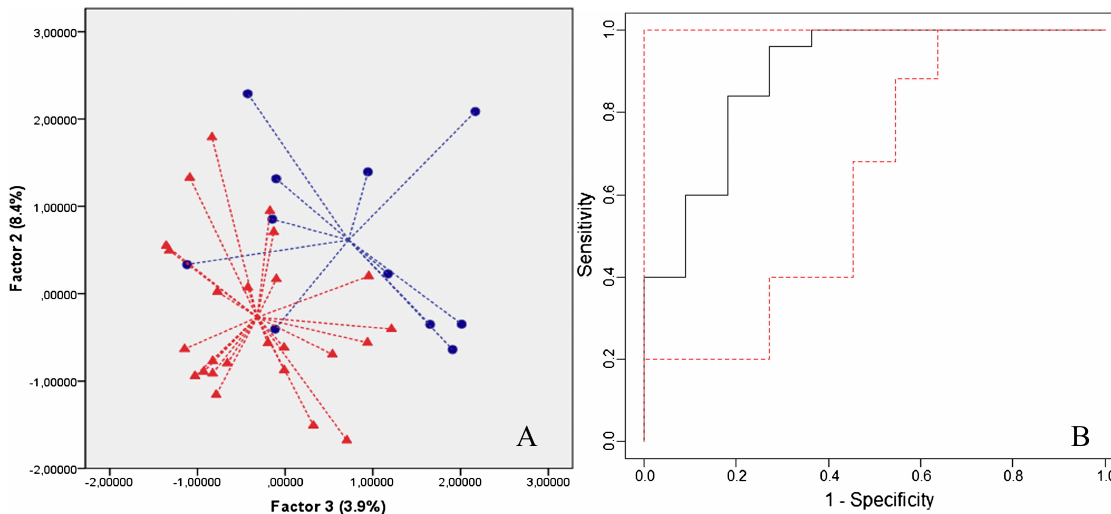
Figure 15. ( A ) Two-dimensional principal component analysis with two composite factors showing the discrimination of breathprints between patients with untreated sarcoidosis (blue circles) and controls (red triangles) and ( B ) ROC-curve with 95% confidence interval for diagnosis of untreated sarcoidosis compared to controls. AUC was 0.825. Comma between numbers in (A) represent decimal places. Used with permission from [94].